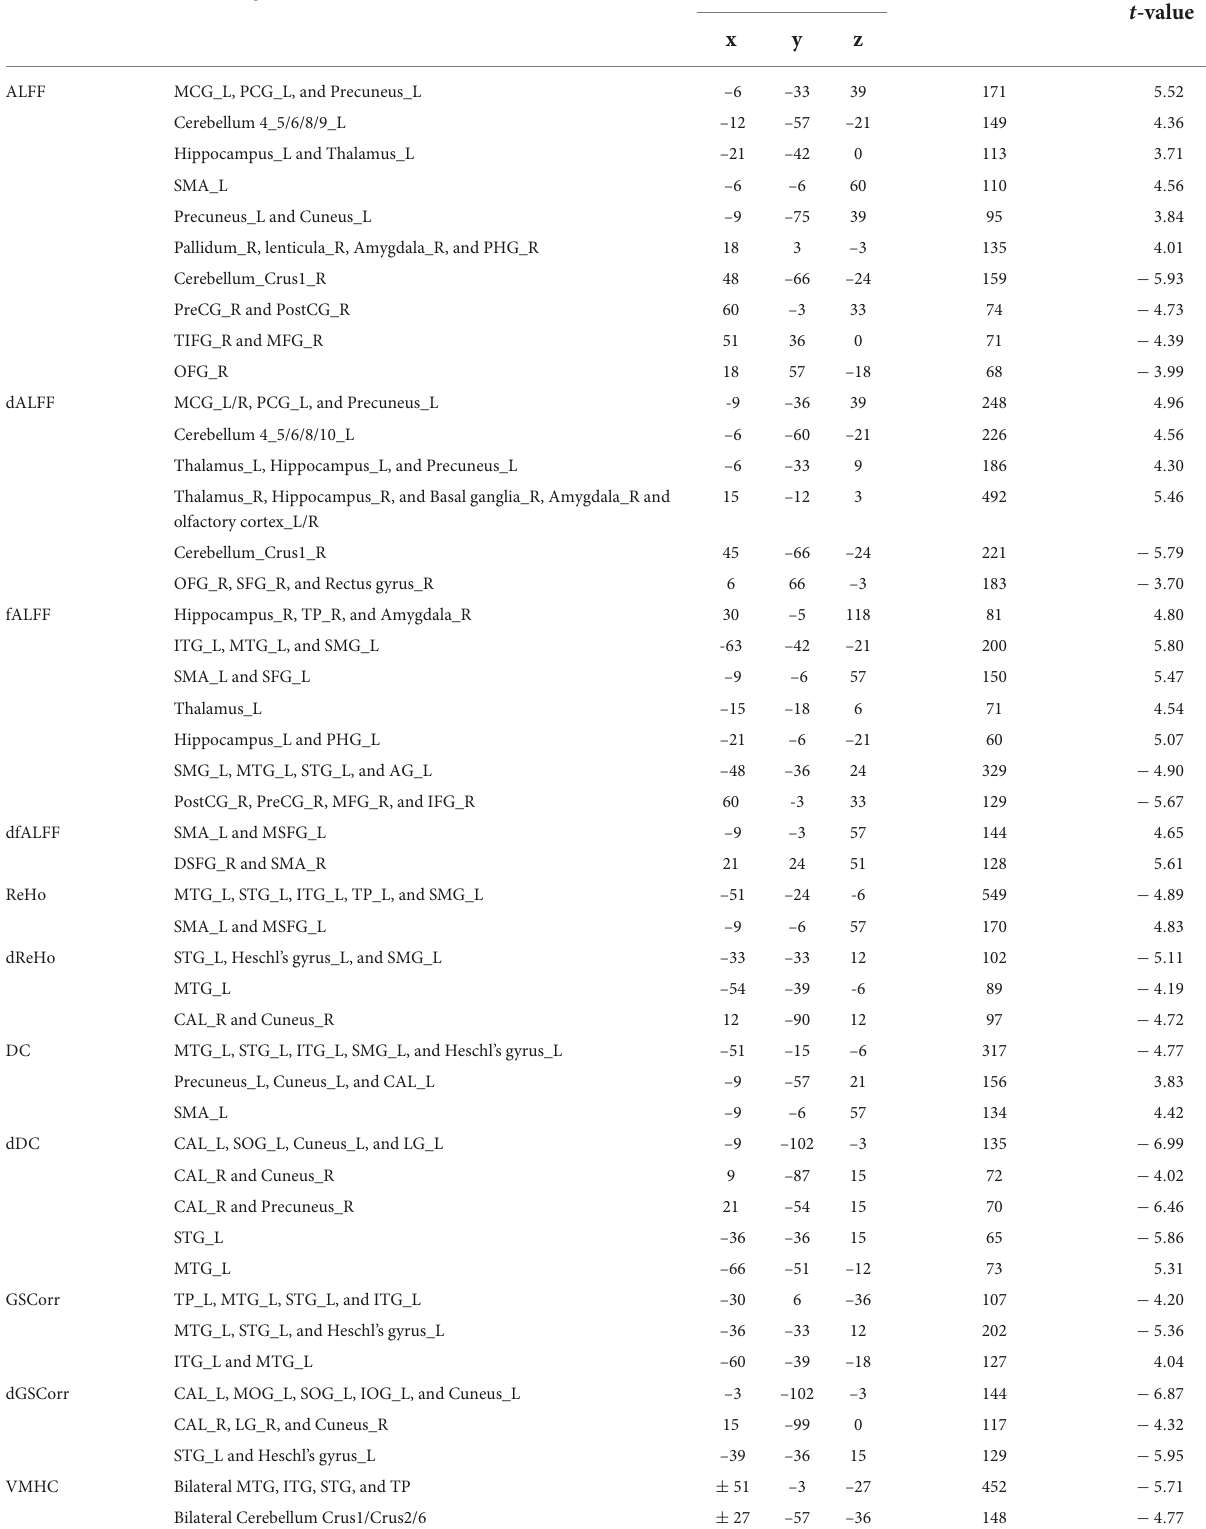
TABLE 2 Brain regions with significant differences of IBA indicators between TLE and HC